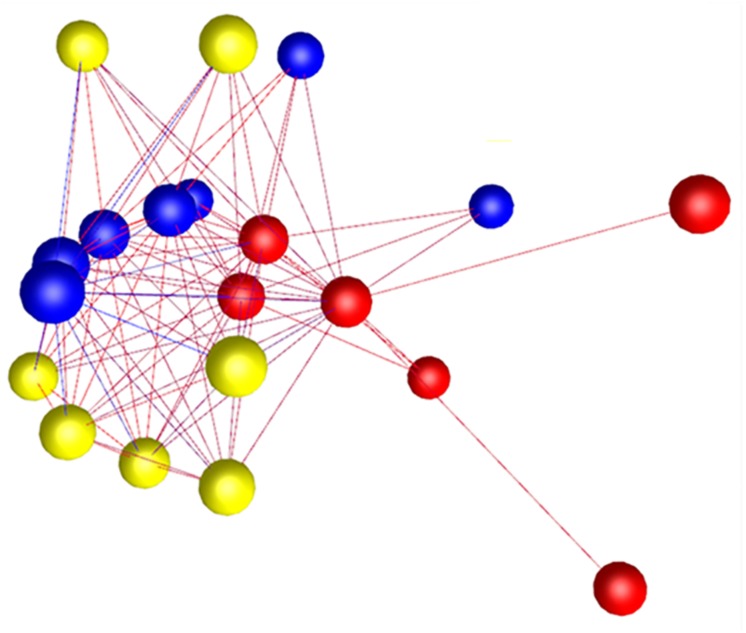
Graphia Pro 1.4 sample-to-sample correlation (r = 0.9) of transcriptomic profiling data from dissected “normal” and dissected “diseased” regions from grade 2 valves, and whole normal valve (grade 0), illustrating gene clustering differences; whole normal valve samples – red, grade 2 normal region – blue and grade 2 diseased region – yellow. Edge color represents degree of correlation (red being stronger and blue being weaker).